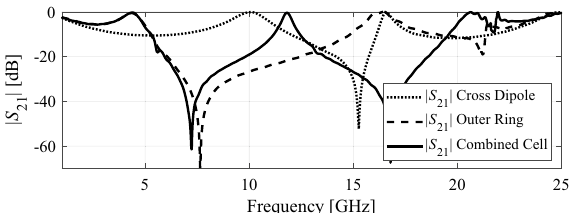
Figure 3. Comparison of transmission coefficients (|S 21 |) of the cross-dipoles, the outer ring, and their